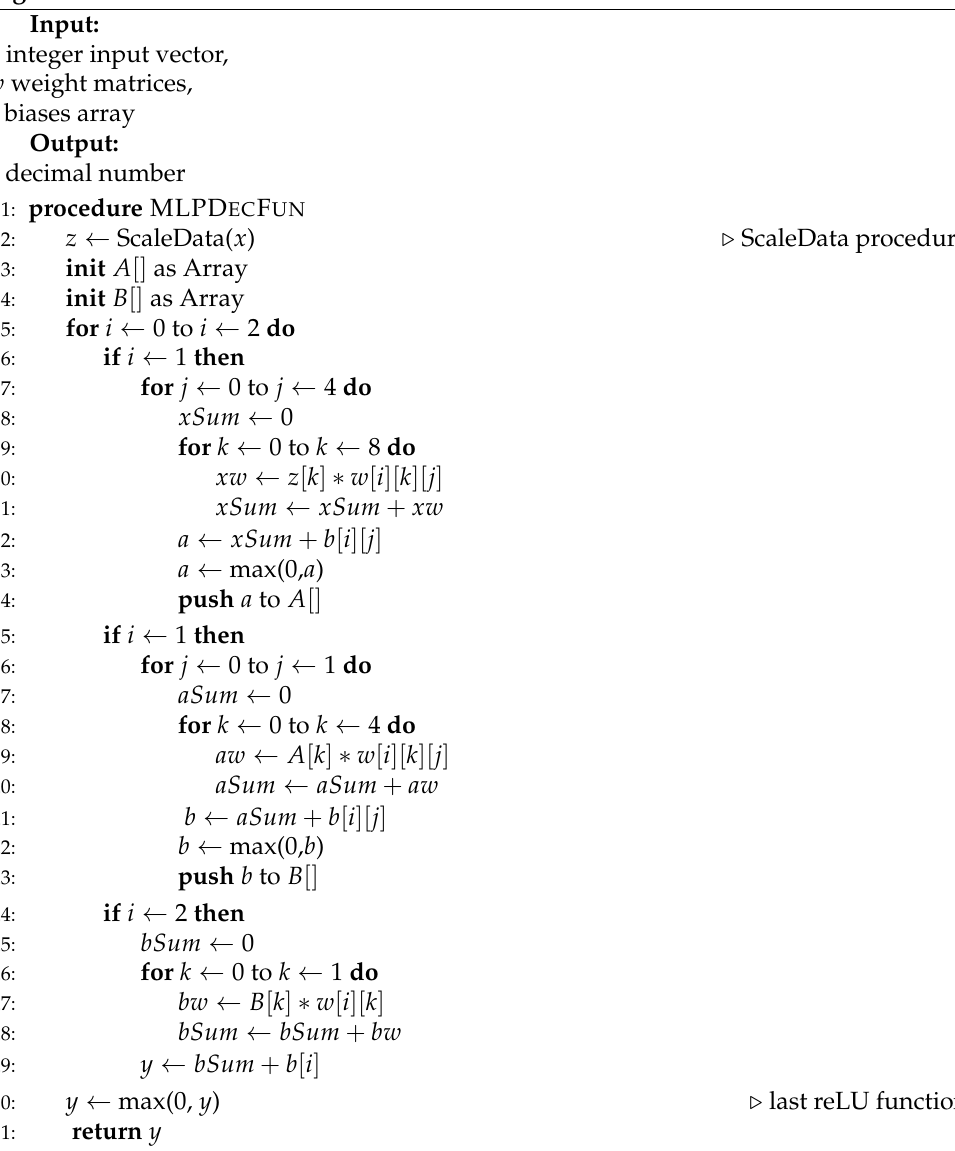
Algorithm 8 MLP decision